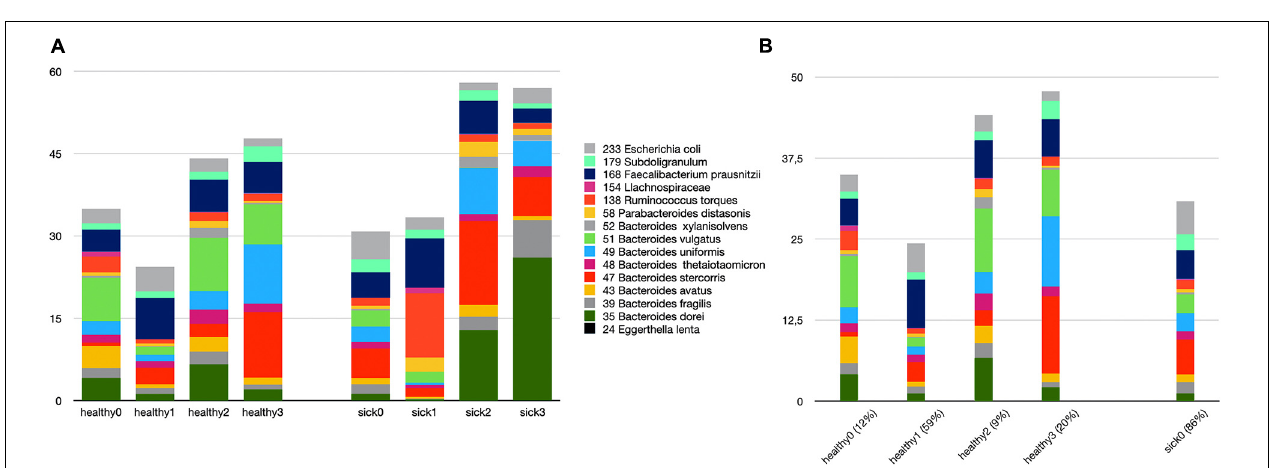
FIGURE 4 | Pairwise correlation heat map of 15 commonly identified features. While number 1 (shown in yellow) indicates full correlation, number 0 (shown in dark blue) indicates no correlation.